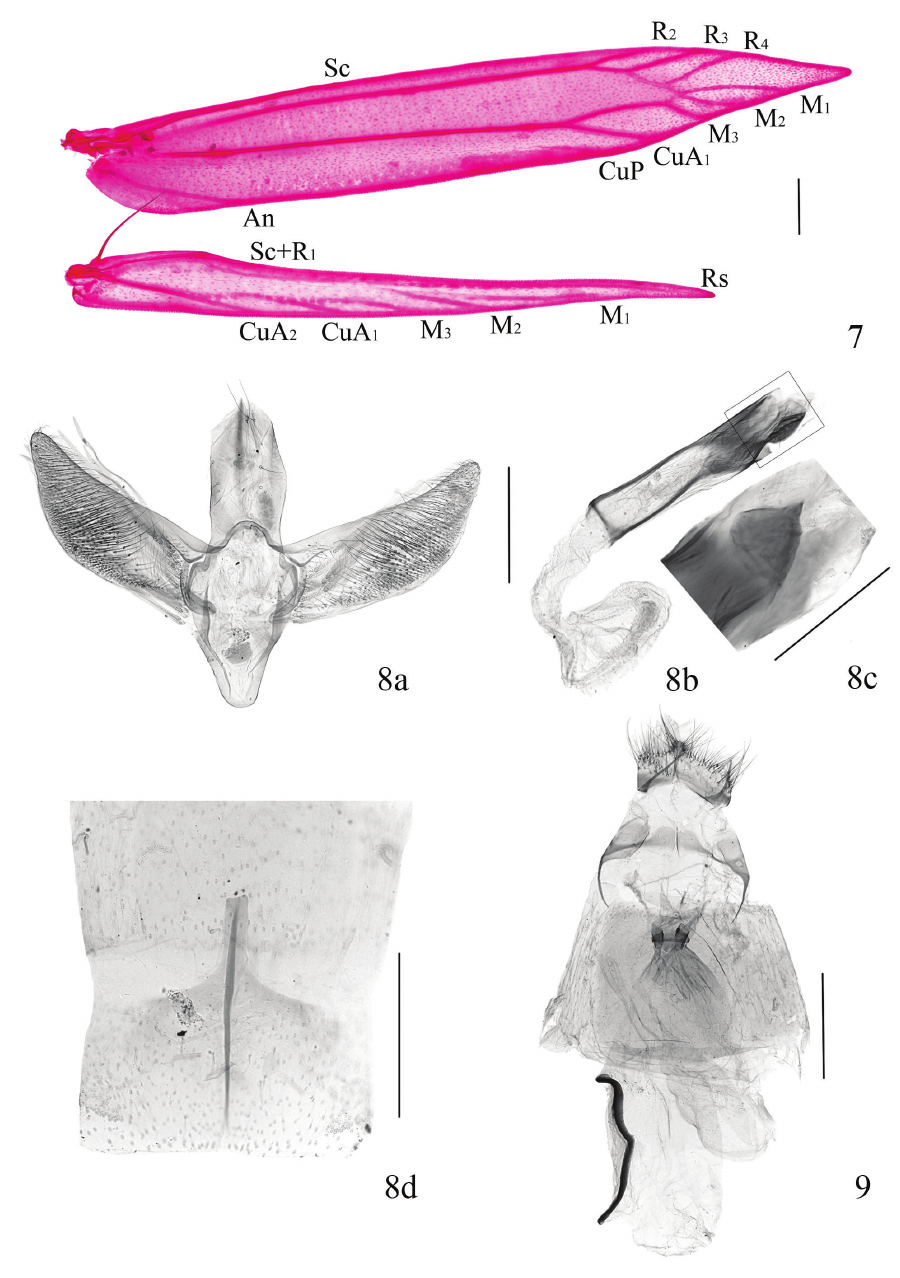
Figures 7−9. Wing venation and genitalia of Telamoptilia grewiae sp. n. 7 Wing venation, paratype, LTT12561W 8 Male genitalia, 8a, male genitalia with aedeagus detached, LTT12561 8b aedeagus, lat- eral view, same slide as 8a , 8c close-up of the distal portion of aedeagus, indicating the triangular process, dorsal view, LTT12257, 8d, eighth abdominal segment, paratype, same slide as 8a, 9 Female genitalia, paratype, LTT12555 (Scales = 0.2 mm except 8c = 0.1